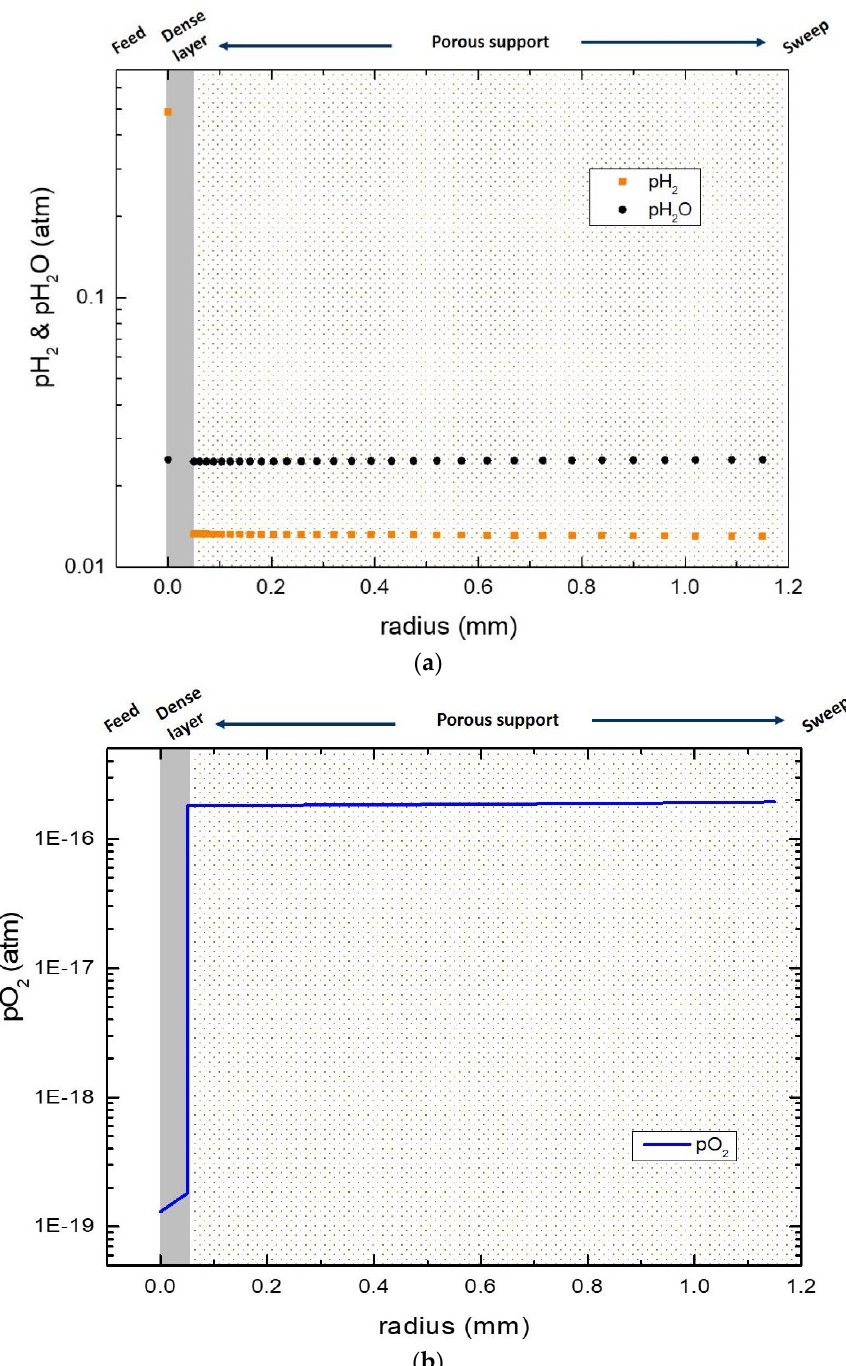
Figure 11. pH 2 , pH 2 O ( a ), and pO 2 ( b ) distribution across the membrane layer and the porous support. The sweep is wet Ar and the temperature is 900 °C.